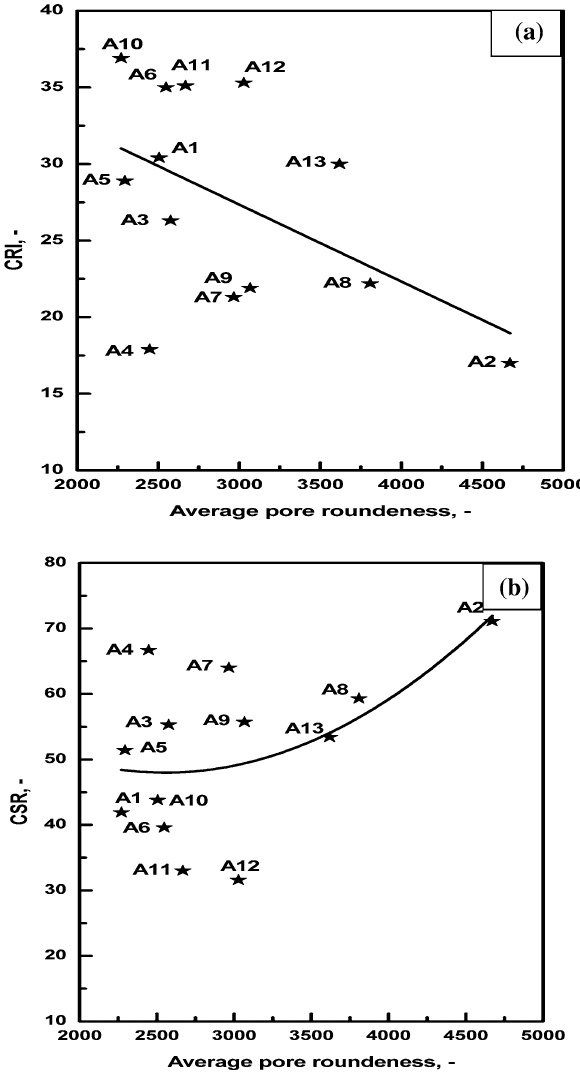
Fig. 7 a Relationship between average roundness of pores and CRI, b relationship between average roundness of pores and